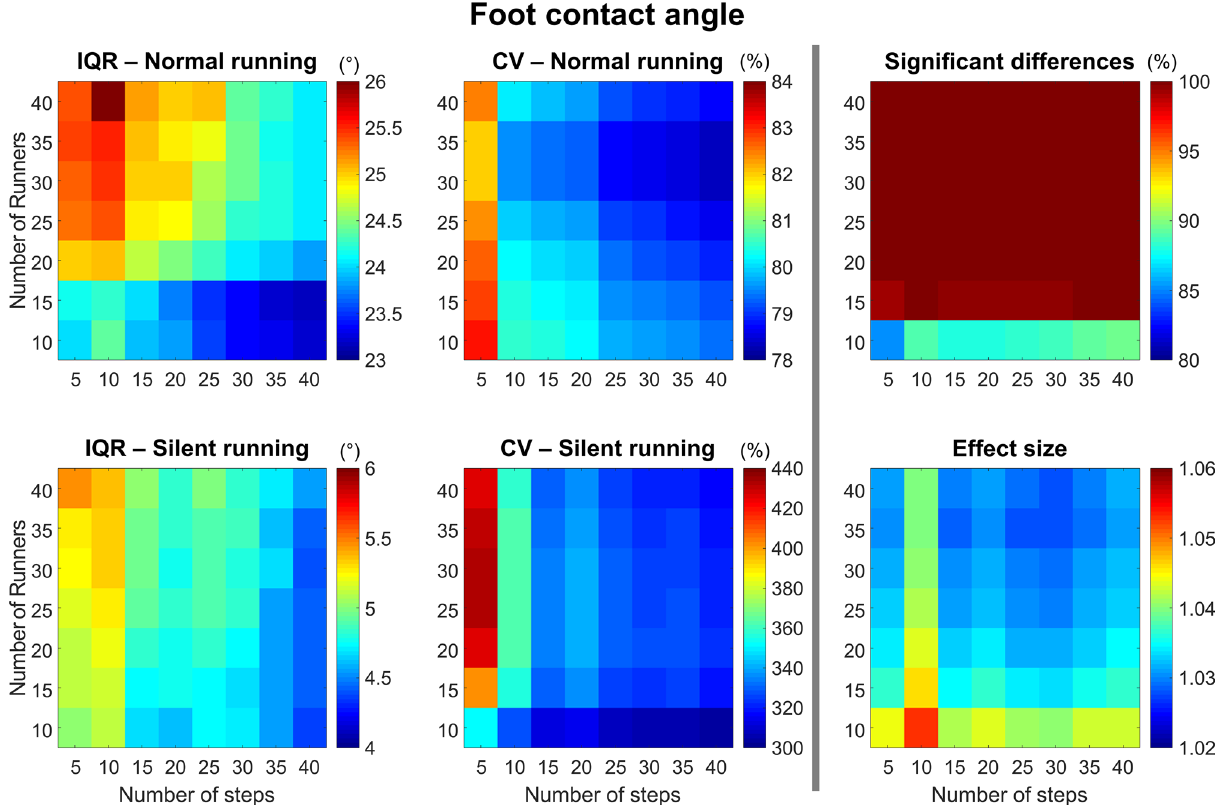
Figure 11. Colormaps demonstrating foot contact angle interquartile range (IQR, left column ) and coefficient of variation (CV, central column ) from the combination of 10–40 runners versus 5–40 running steps. Data is shown from normal running ( top panels ) and silent running ( bottom panels ). Each value is an average from 100,000 paired permutations for each combination. The number of significant differences ( p < 0.05, expressed as a percentage of 100,000 comparisons, top right panel ) and their respective effect size ( bottom right panel ) illustrate the changes in statistical outcomes depending on the combination of number or runners versus number of steps.